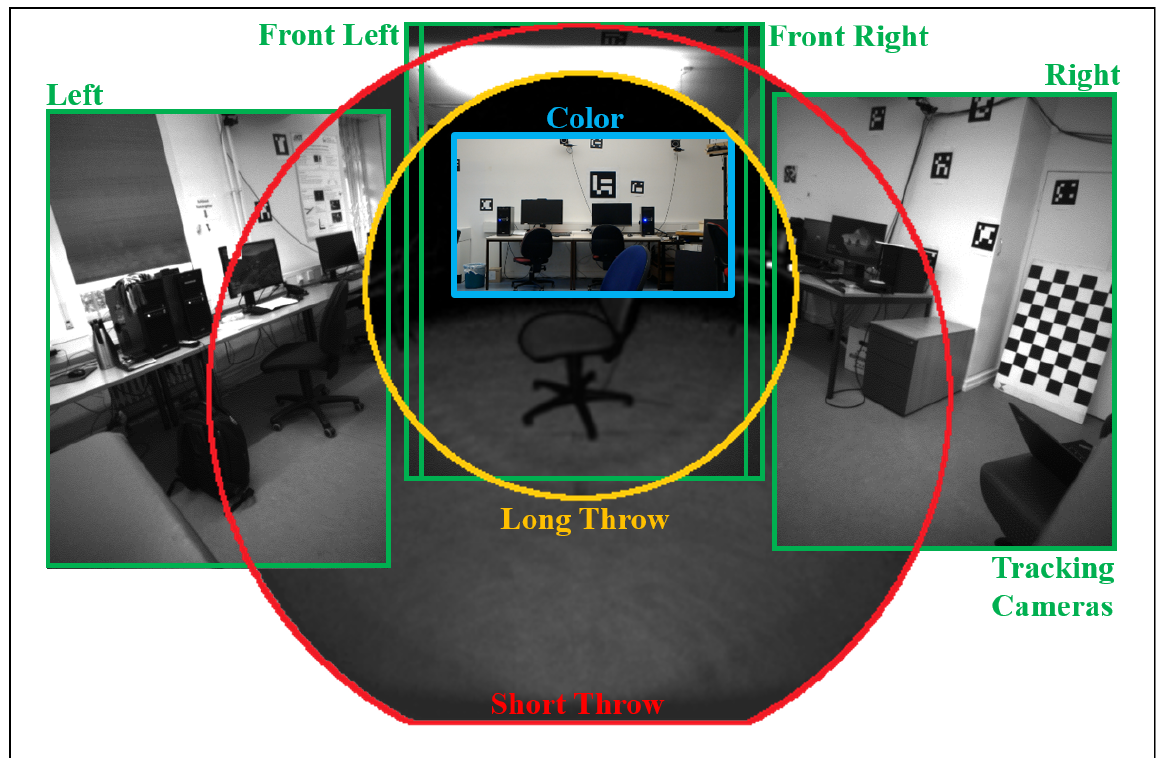
Figure 2. Overlay of images recorded by the different camera sensors of the Microsoft HoloLens as specified in Table 1.